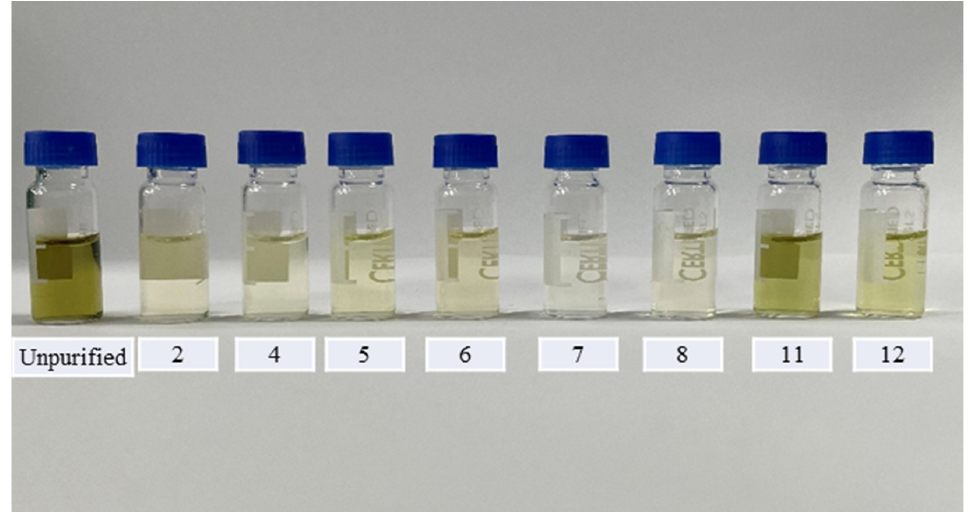
Figure 4. The adsorption effects of eight different adsorption agents for purifying the interfering components in D. officinale . (2) 10 mg MWCNT (short) + 50 mg MgSO 4 , (4) 10 mg g-MWCNTs + 150 mg MgSO 4 , (5) 10 mg g-MWCNTs + 150 mg MgSO 4 , (6) 10 mg MWCNTs-COOH + 150 mg MgSO 4 , (7) 10 mg MWCNTs-NH 2 + 150 mg MgSO 4 , (8) 10 mg MWCNTs-OH + 150 mg MgSO 4 , (11) 50 mg PSA + 50 mg C18 + 150 mg MgSO 4 , (12) 10 mg ZrO 2 + 150 mg MgSO 4 .